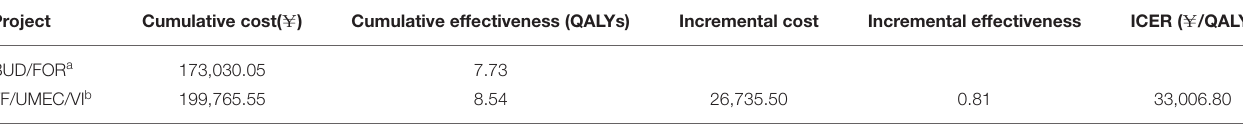
TABLE 4 | Basic analysis results.